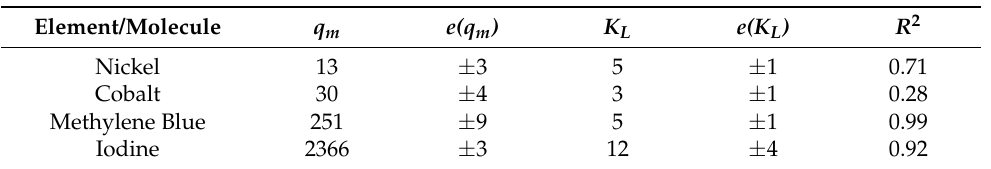
Table 4. Parameter results of q m and K L from the linear fitting between C e /q e and C e using modified = Langmuir adsorption equation: C e q e